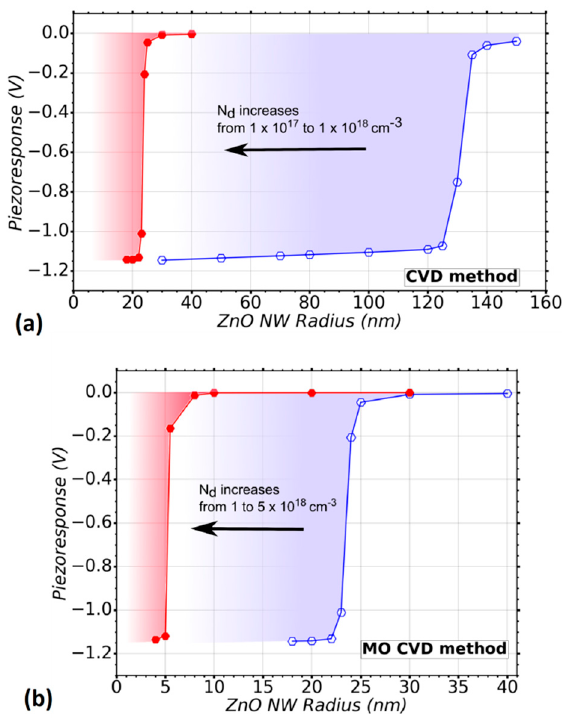
Figure 5. Variation of the piezoresponse of a VING as a function of ZnO NW radius taking into account two vapor deposition techniques for the growth : CVD and MOCVD. ( a ) A range of doping levels (N d ) from 1 × 10 17 ( ) to 1 ( ) × 10 18 cm –3 is considered, which is typical in the CVD method, ( b ) a range of doping level (N d ) from 1 ( ) to 5 ( ) × 10 18 cm –3 is considered, which is typical in MOCVD method. A trap density N it = 1 × 10 12 eV –1 cm –2 was considered in the simulations.